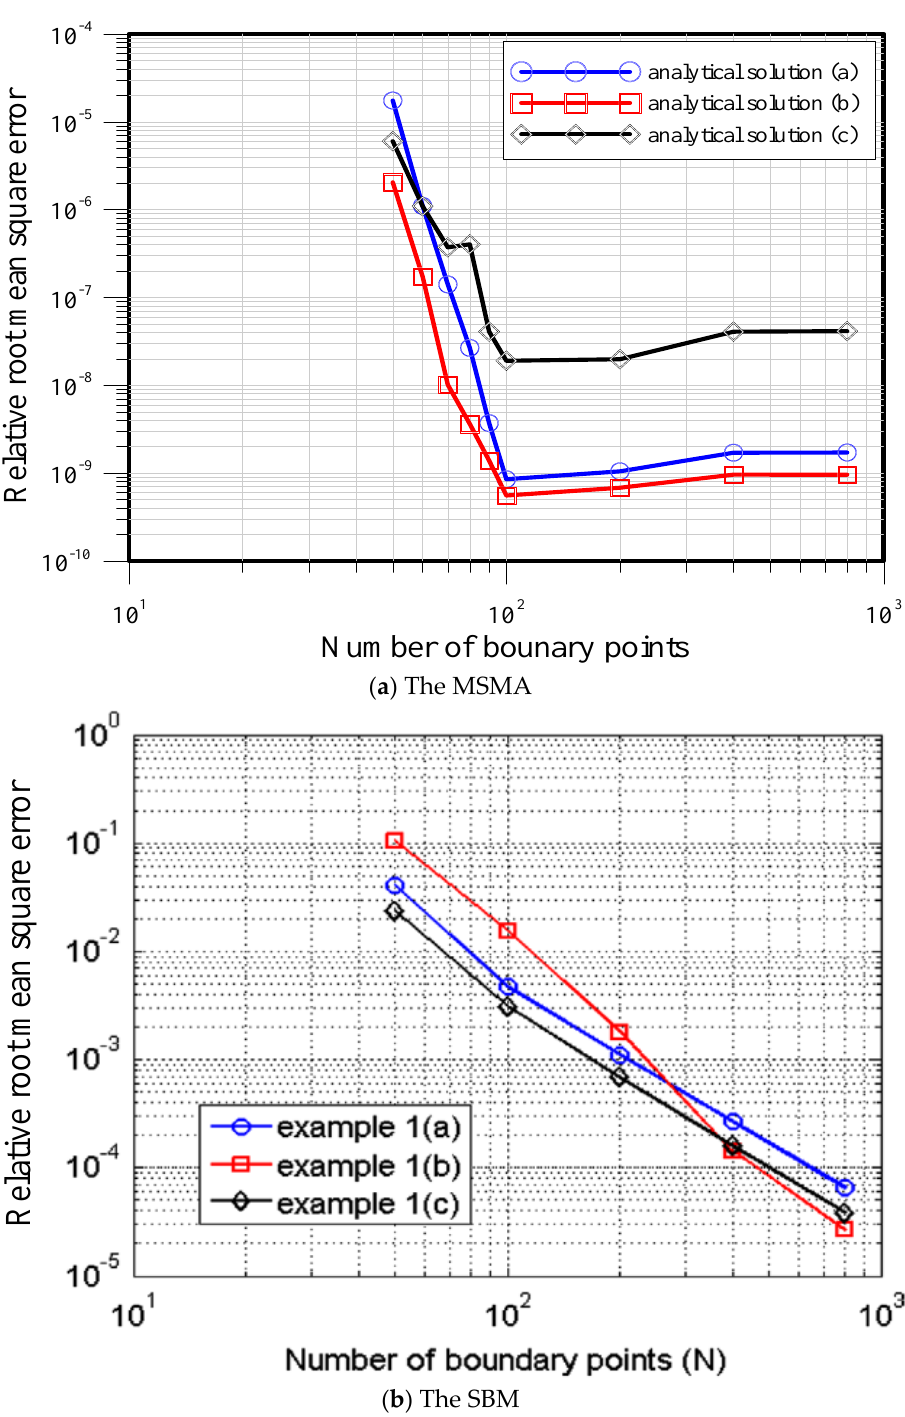
Figure 8. Comparison of the accuracy with the MSMA and the singular boundary method (SBM): ( a ) the MSMA and ( b ) the SBM.